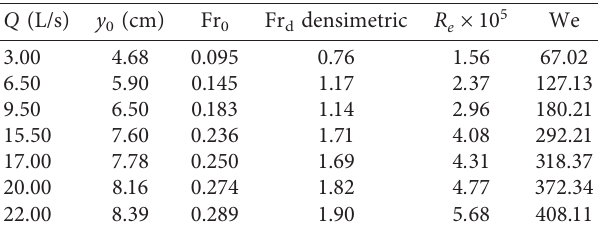
Table 4: Froude similarity modeling and calculated Reynolds, Weber, and Froude